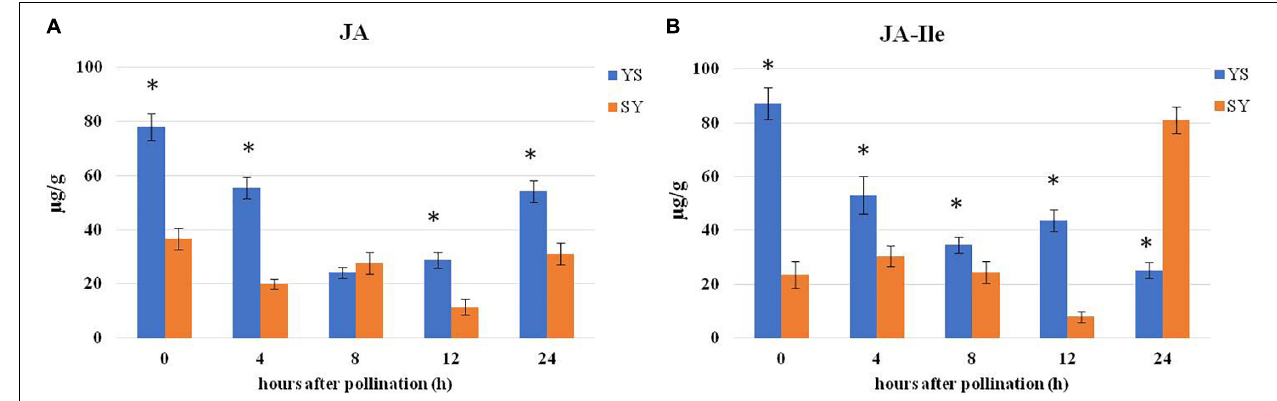
FIGURE 9 | Comparison of hormone levels in pistils of SY and YS. (A) Jasmonic acid content. (B) JA-Ile content 0, 4, 8, 12, and 24 h after pollination. YS, × Shixia × Yiduo Yiduo ; SY, Shixia . Asterisk on the bars show significant differences ( p < ♀ ♀ ♂ ♂